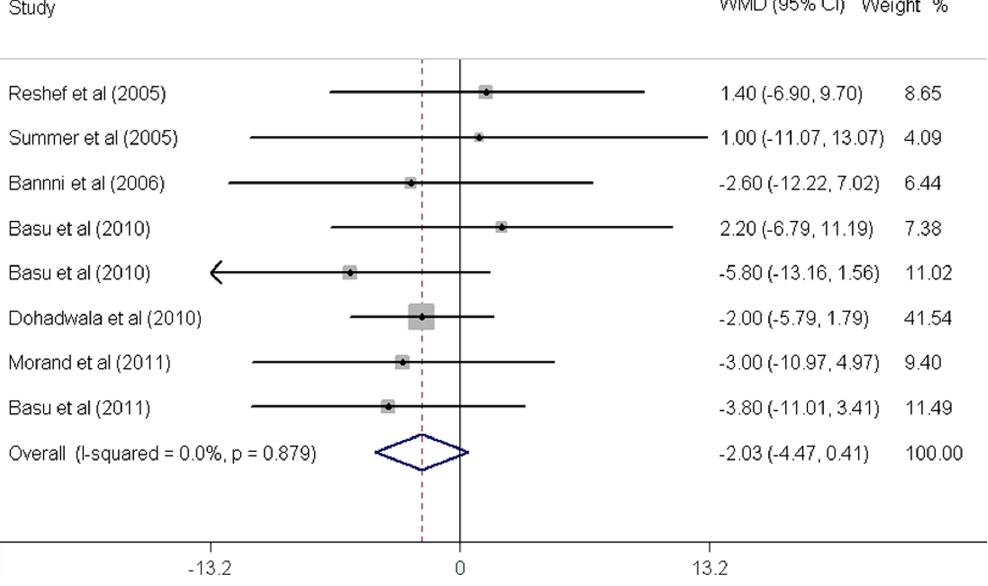
Figure 6. Meta-analysis of effects of fruit juice on systolic blood pressure (SBP). The result was obtained from a fixed-effects model. Sizes of data markers indicate the weight of each study in this analysis. WMD, weighted mean